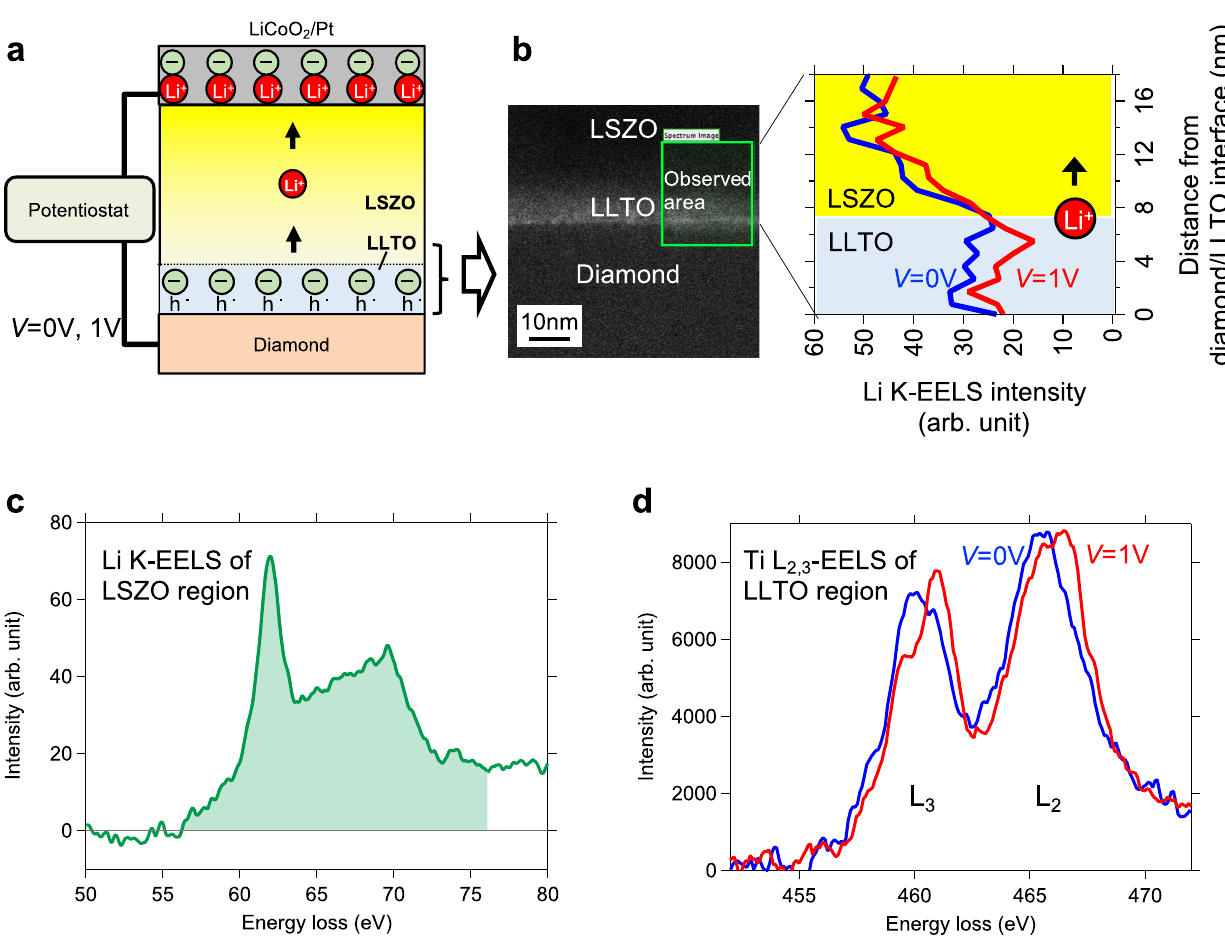
Fig. 5 In situ STEM-EELS observation at a diamond electrode/LLTO interlayer interface. a Illustration of the two terminal cell with a diamond working electrode, an LSZO electrolyte, and an LCO/Pt counter/reference electrode for in situ STEM-EELS. Li + in the electrolytes is shown only as indicators of the polarity of the electric current. b TEM image near the diamond/LLTO interlayer interface (left panel) and the depth pro fi le of the Li K-edge intensity under dc voltage ( V = 0 V, 1 V) applied conditions (right panel). c Li K-edge spectrum measured in the LSZO region. Background subtraction and zero loss deconvolution were applied to a raw spectrum in order to remove any plural scattering effect and to obtain the single scattering distribution shown in Fig. 5c. d Ti L-edge spectra measured under 0 V and 1 V applied